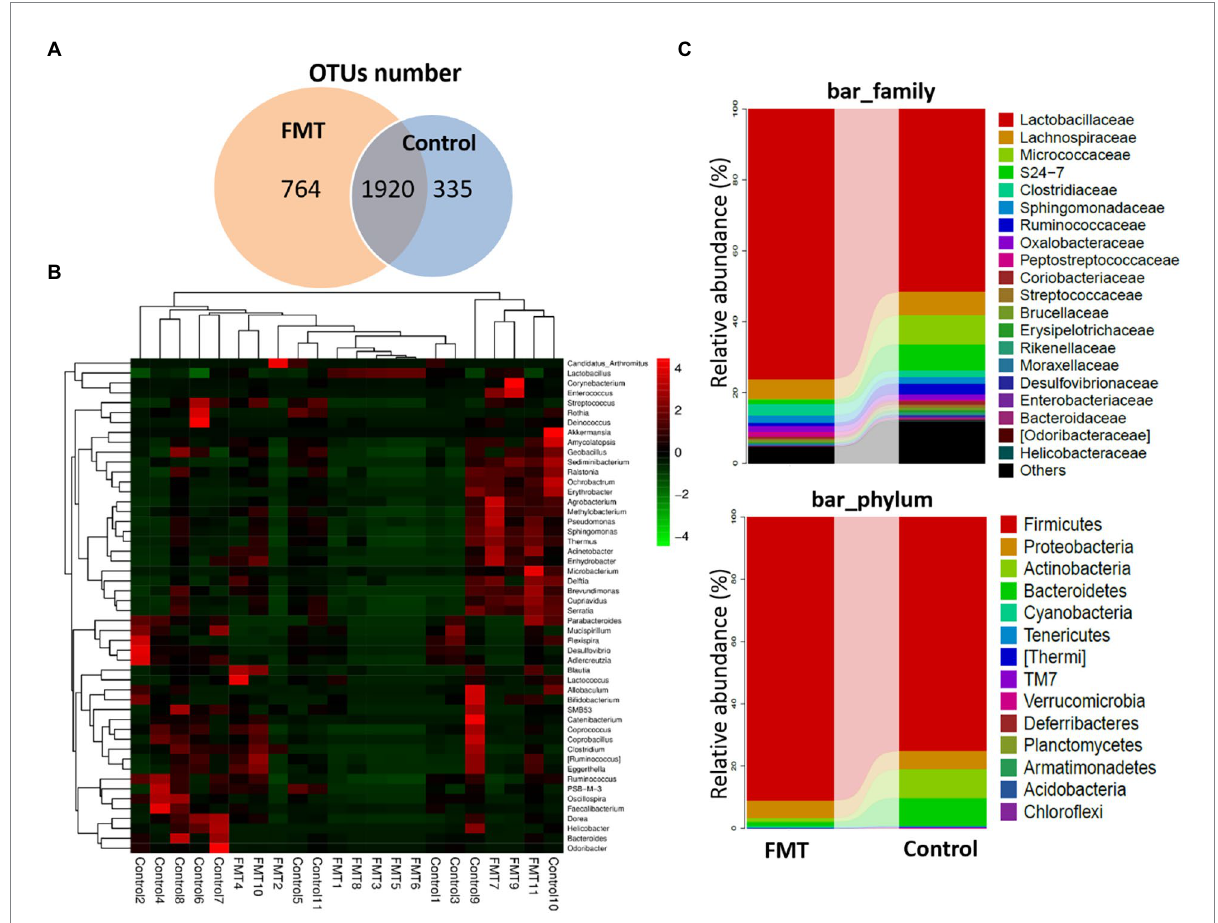
FIGURE 2 Impact of FMT on the Chickens Gut Microbiota Structure. (A) Venn diagram of OUT number between groups (Control and FMT) of common and unique units. (B) Heat map showing the genera with significant differences of relative abundances between groups. (C) Taxonomic composition analysis between groups at each classification level of phylum and family control and FMT